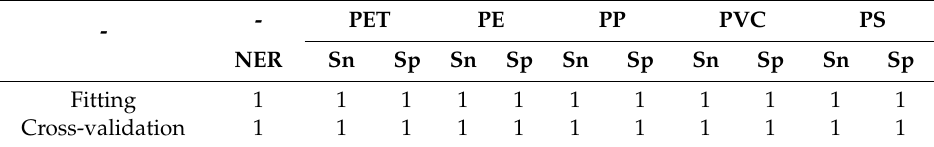
Table 2. Classification parameters (non-error rate (NER), class sensitivity (Sn), and specificity (Sp)) calculated in fitting and in cross-validation.